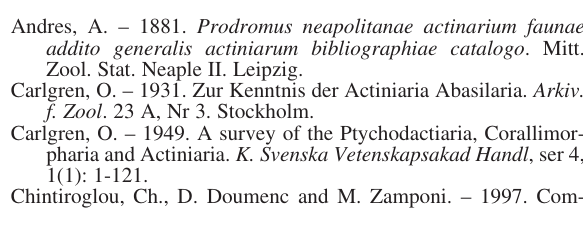
Table 2 for explanation. Scale bar: 10 µm.